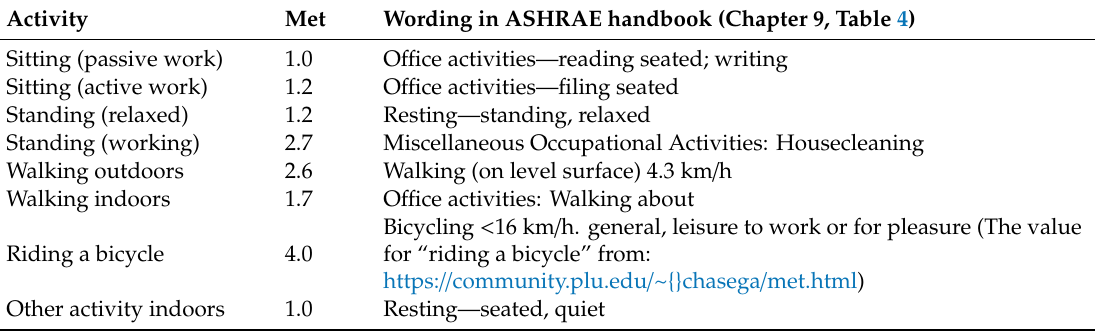
Table A2. List of activities used in the questionnaire and the Met values